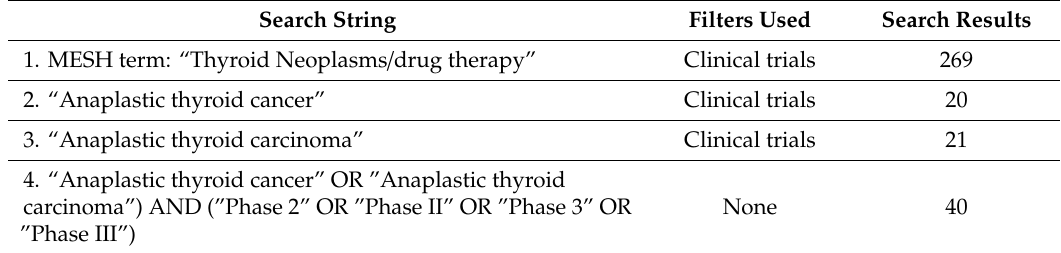
Figure 2. Flow diagram for study selection. Table 4. Search strings used in systematic search on PubMed.